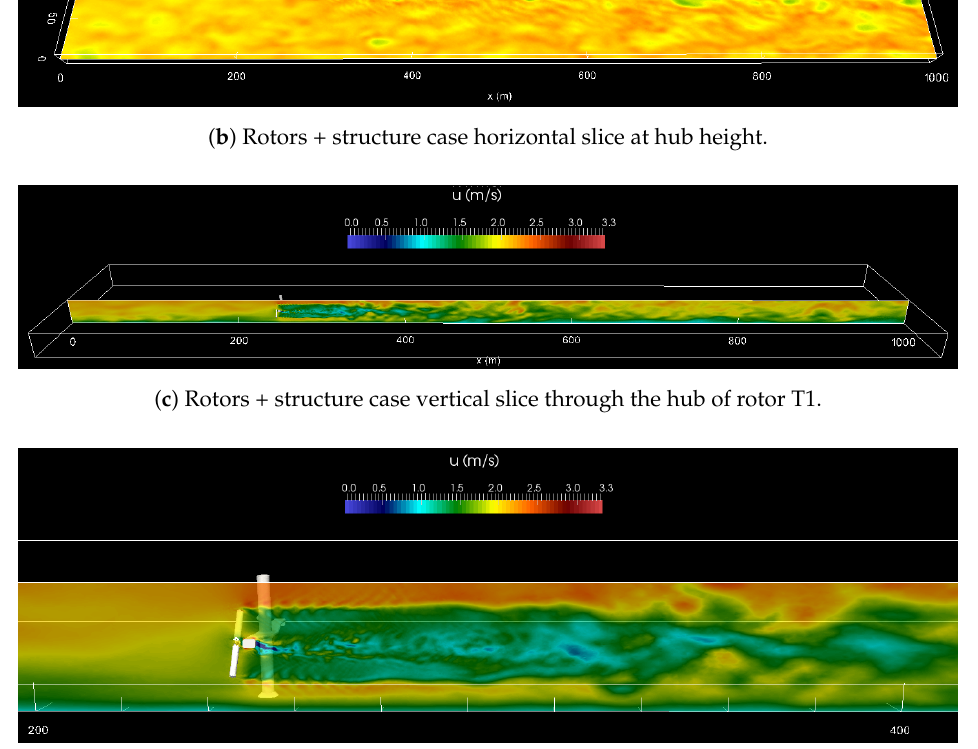
Figure 15. Instantaneous snapshots of the velocity field for rotor and rotor+structure cases, at the end of the